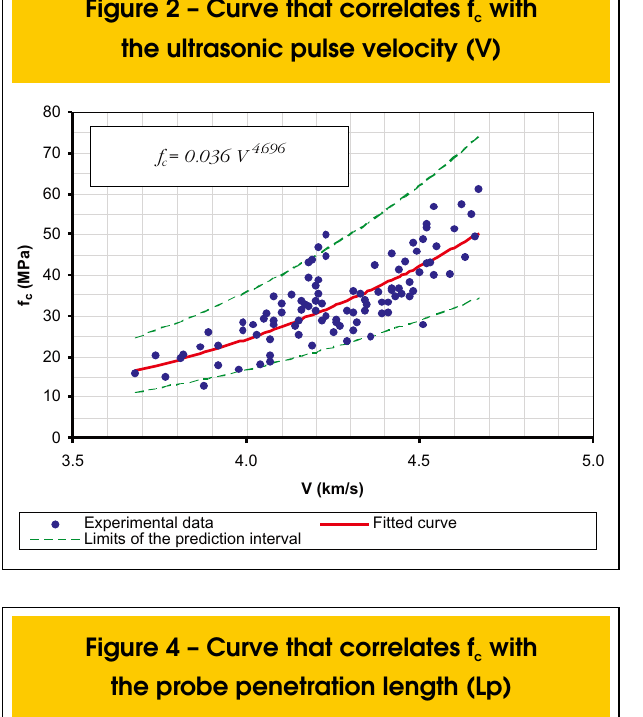
Figure 5 – Curve that correlates E with the ultrasonic pulse velocity